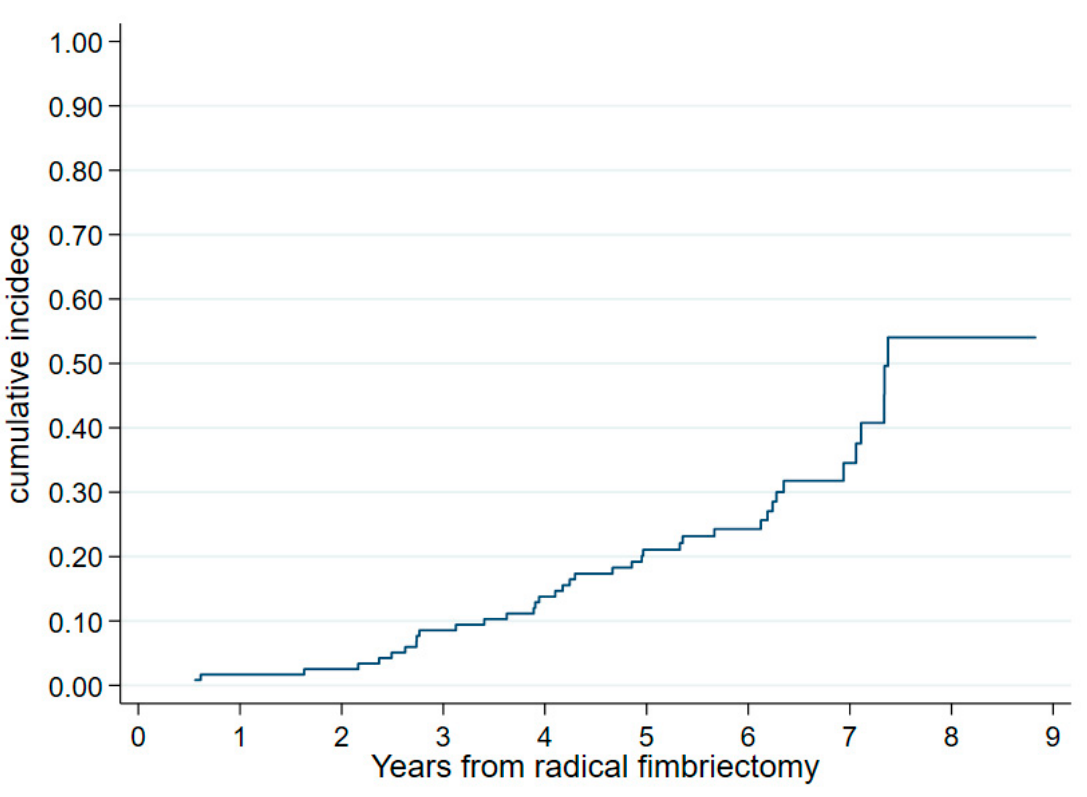
Figure 2. Cumulative incidence of oophorectomy from radical fimbriectomy (N = 119).